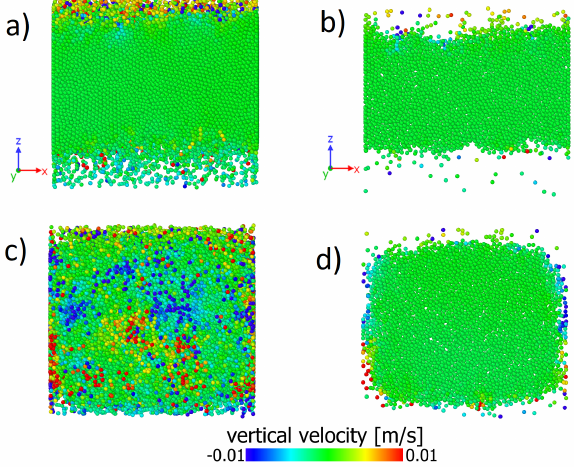
Figure 6. Numerical simulation results of case 3 using a coef- ficient of friction of 0.1 and 0.9. In a) is the full case using a coe ffi cient of friction of 0.1, and in b) is a slice taken from the full case. In c) is the full case using a coe ffi cient of friction of 0.9, and in d) is the corresponding slice taken from the full case. See Fig. 4 a) and b) for correct spatial location of the slice